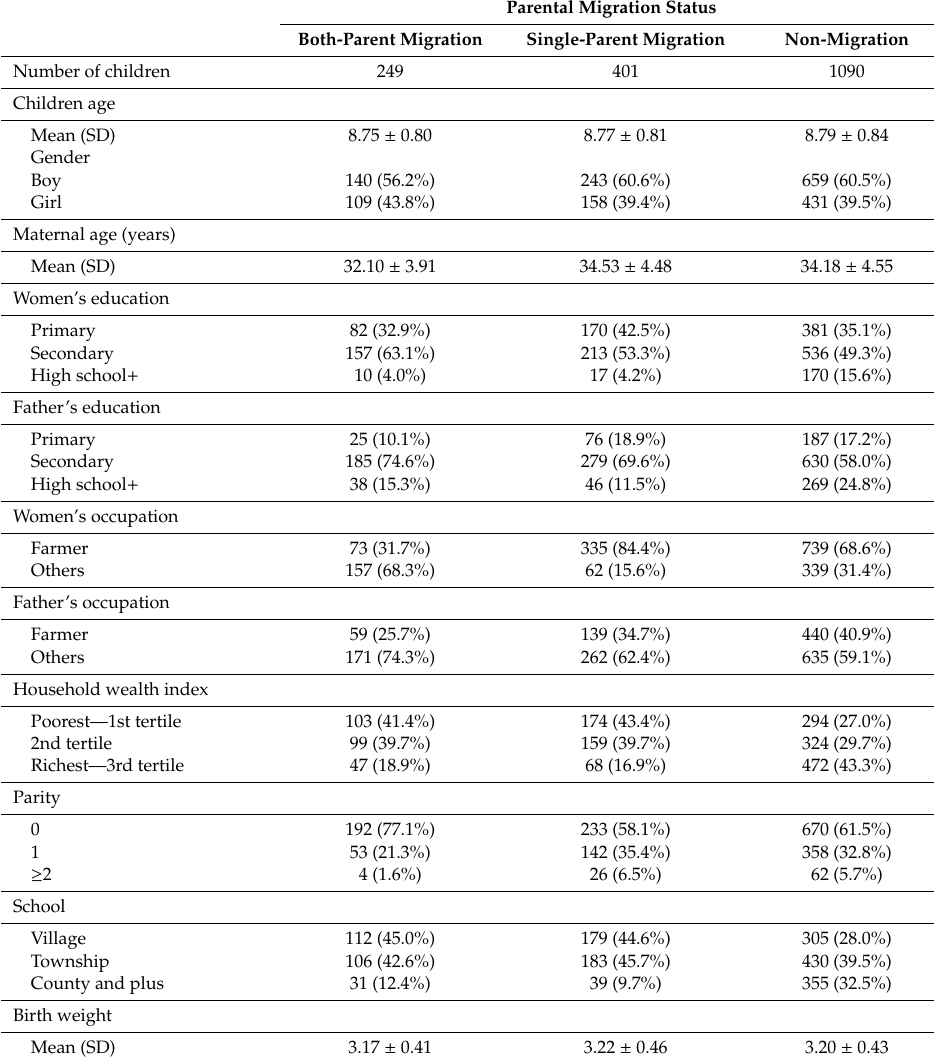
Table 1. Baseline Characteristics of Children, Their Mothers and Households in Di ff erent Group a